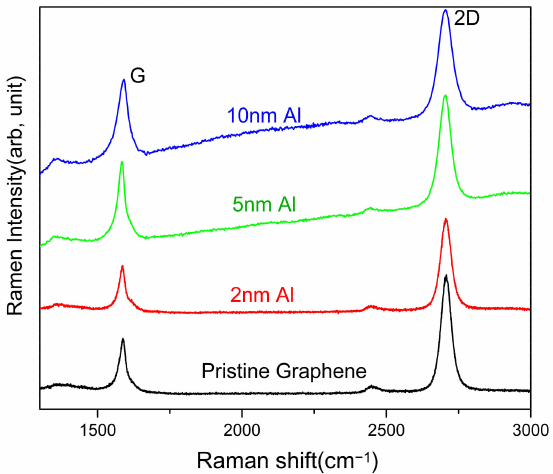
Figure 2. SEM images of different thicknesses Al films deposited by e-beam evaporation on the CVD graphene surface and naturally oxidized to Al 2 O 3 in air: ( a ) 2 nm; ( b ) 5 nm; ( c ) 10 nm. SEM images of corresponding samples after further ALD of 10 nm Al 2 O 3 : ( d ) 2 nm; ( e ) 5 nm; ( f ) 10 nm.